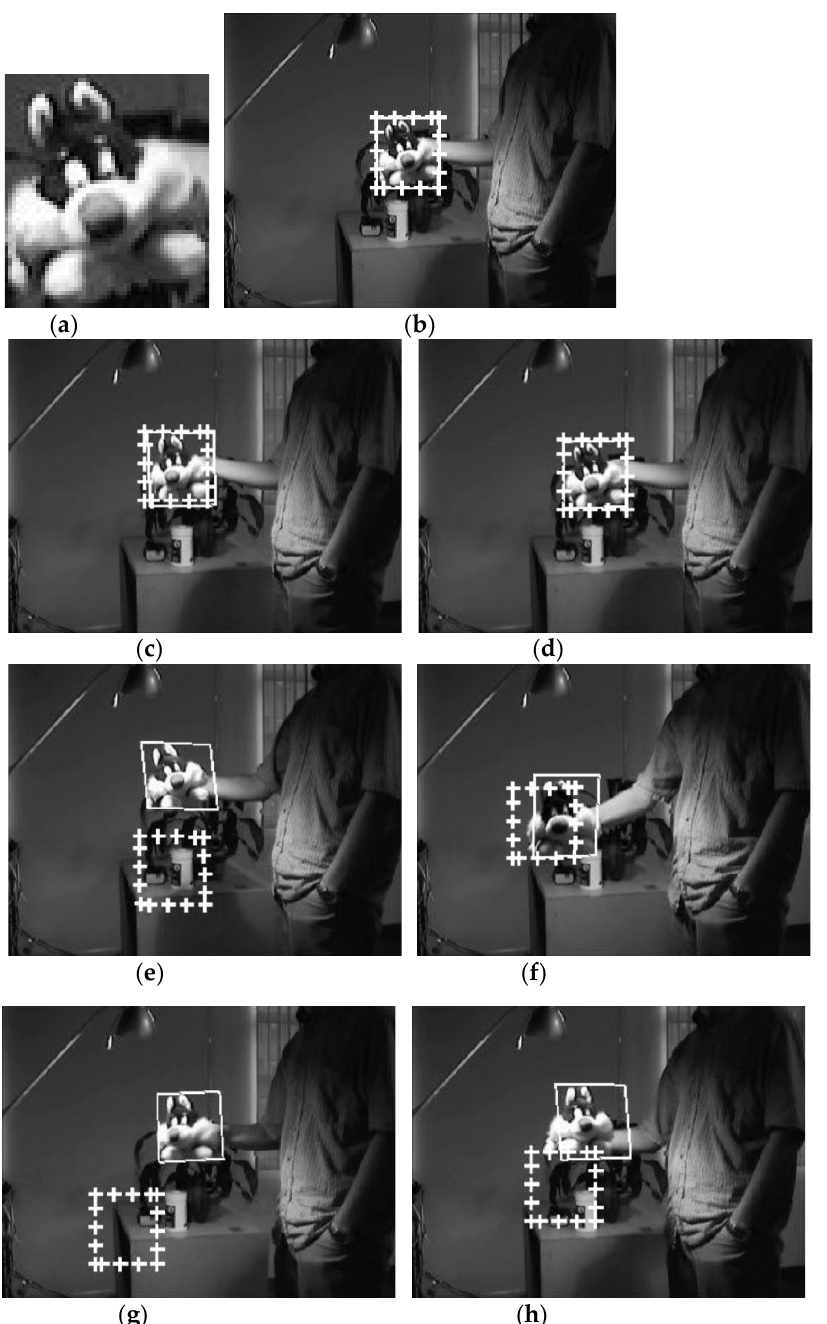
Figure 8. Selected results of object detection using Sylvester open data sets [23]. The first image ( a ) is the template. The object detection problem is to find the same object as the template in various images with different poses and sizes from the template, such as images ( b )–( h ).